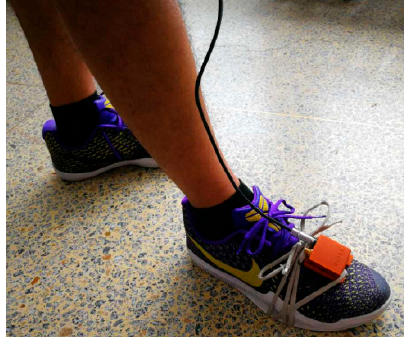
Figure 3. Inertial measurement unit (IMU) strapped on to a shoe.